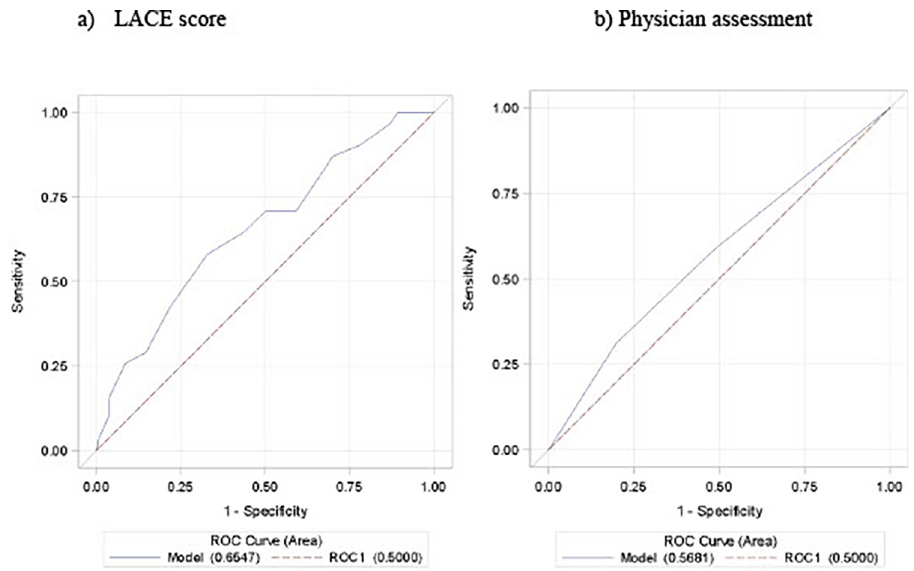
Fig 2. Receiver Operating Curve (ROC) for LACE score and physician assessment.